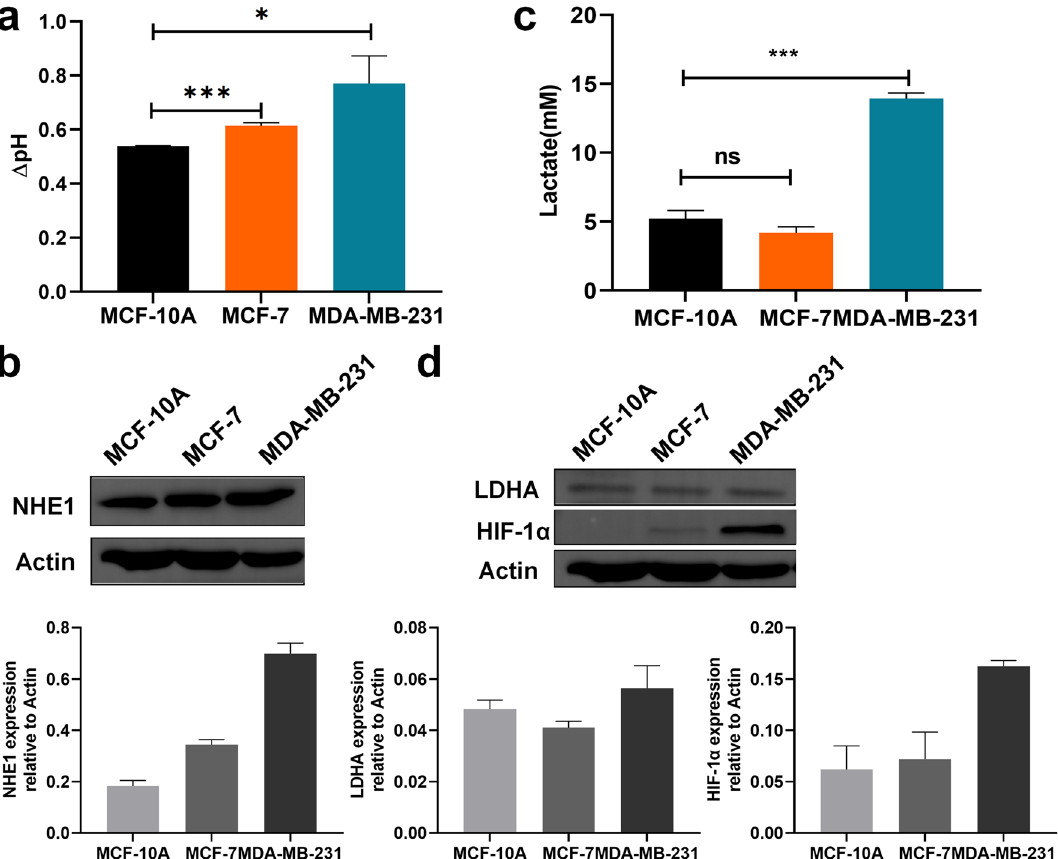
Figure 4. Changes in lactic acid and NHE1 levels in the acidic microenvironment of three types of cells. ( a ) Decrease in pH of culture media for 3 types of breast cells. ( b ) Western blot of NHE1. ( c ) The amount of lactic acid secreted in the three types of cell media. ( d ) Western blot of LDHA and HIF-1α. (Data are means ± SEM, n = 3). *p < 0.05; **p < 0.01; **p <